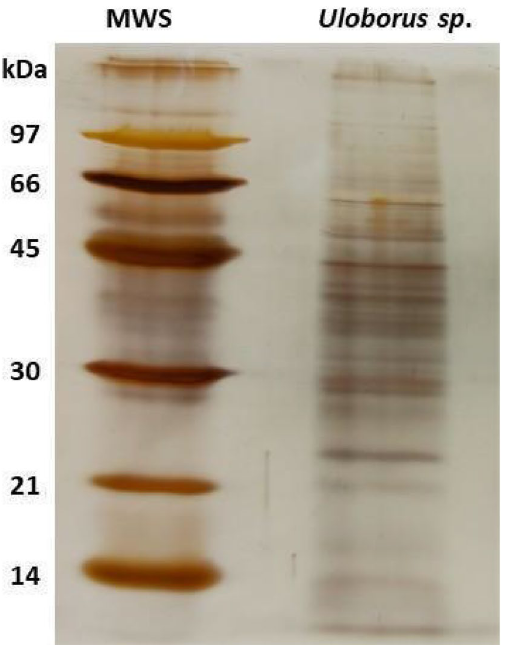
Figure 1. SDS PAGE profile of midgut samples from Uloborus sp. About 10 μg of proteins from the midgut of Uloborus sp. was submitted to electrophoresis in a 12% polyacrylamide gel at 150 V. MWS—Molecular